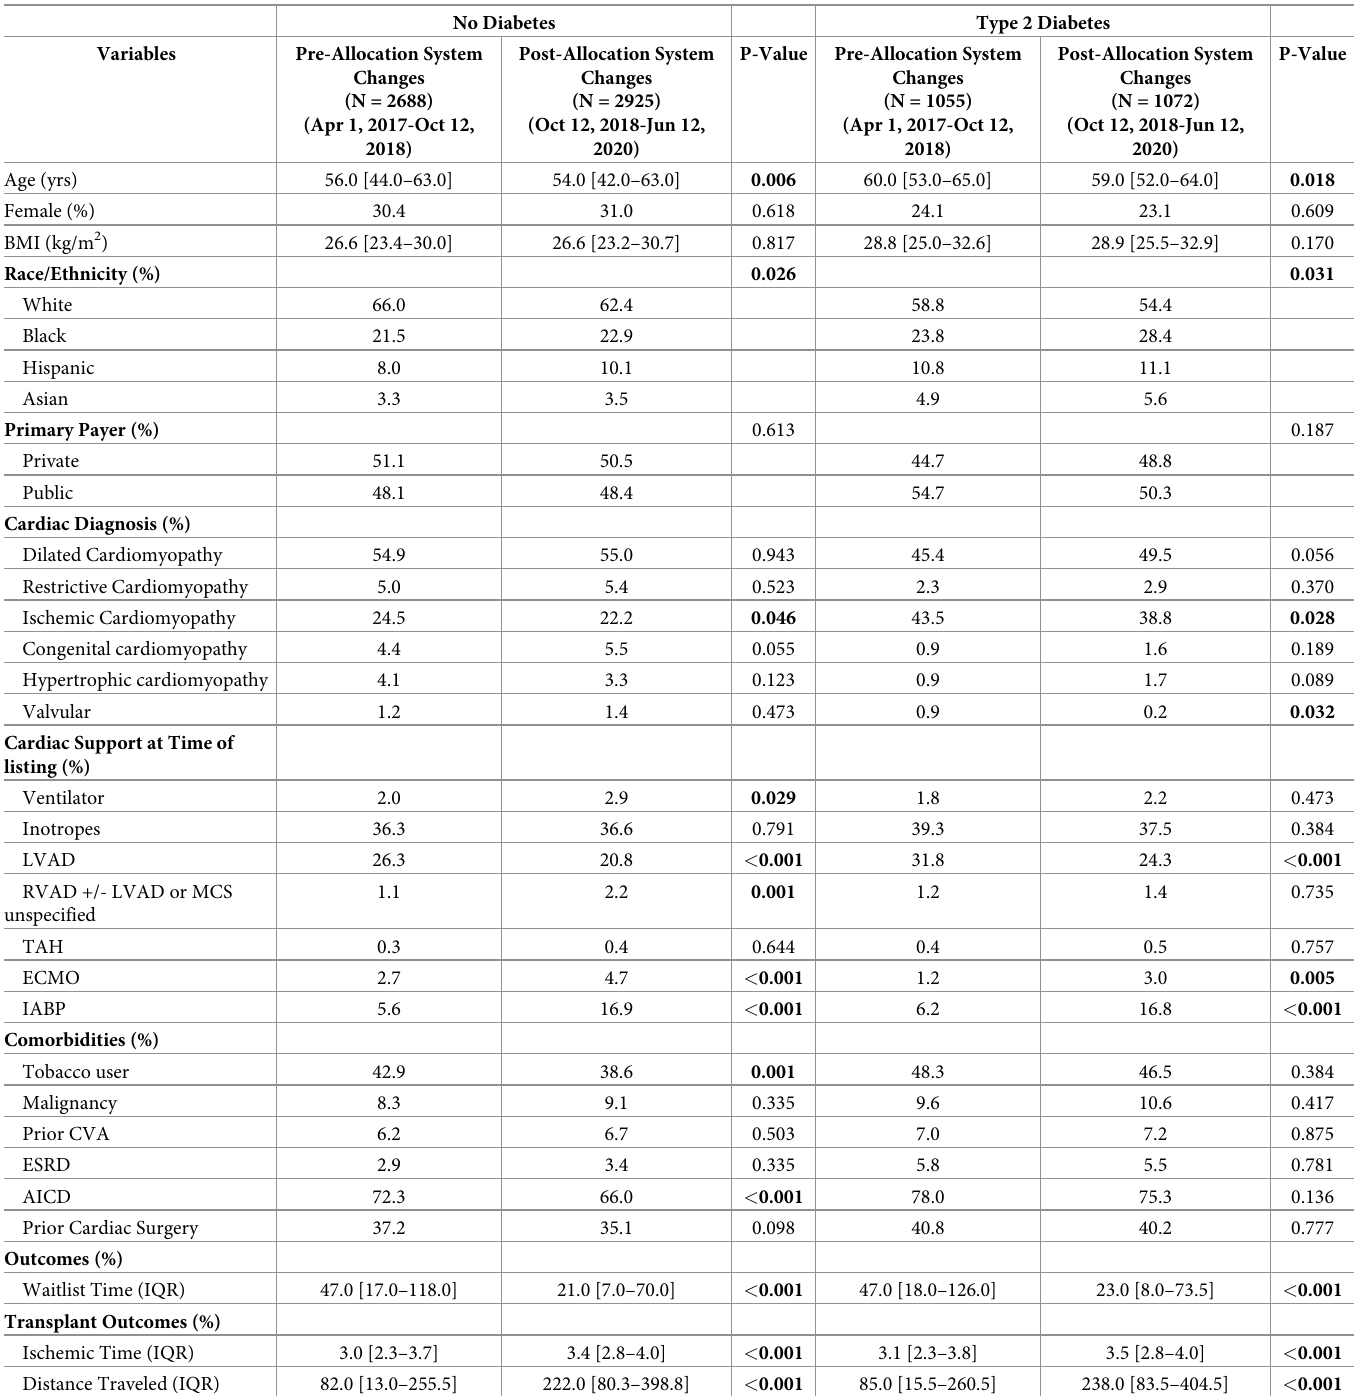
Table 6. Differences based on allocation